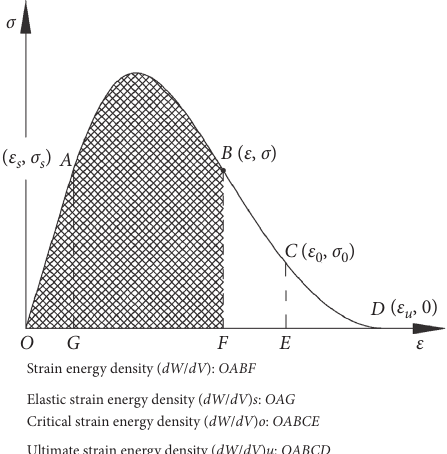
Figure 9: Stress-strain relation curve of rock under high stress.